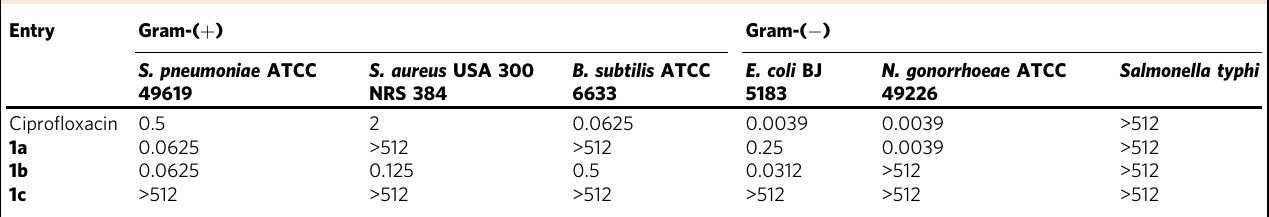
Table 1 MIC values ( μ g/mL) of albomycins δ 1 (1a), δ 2 (1b), and ε (1c)